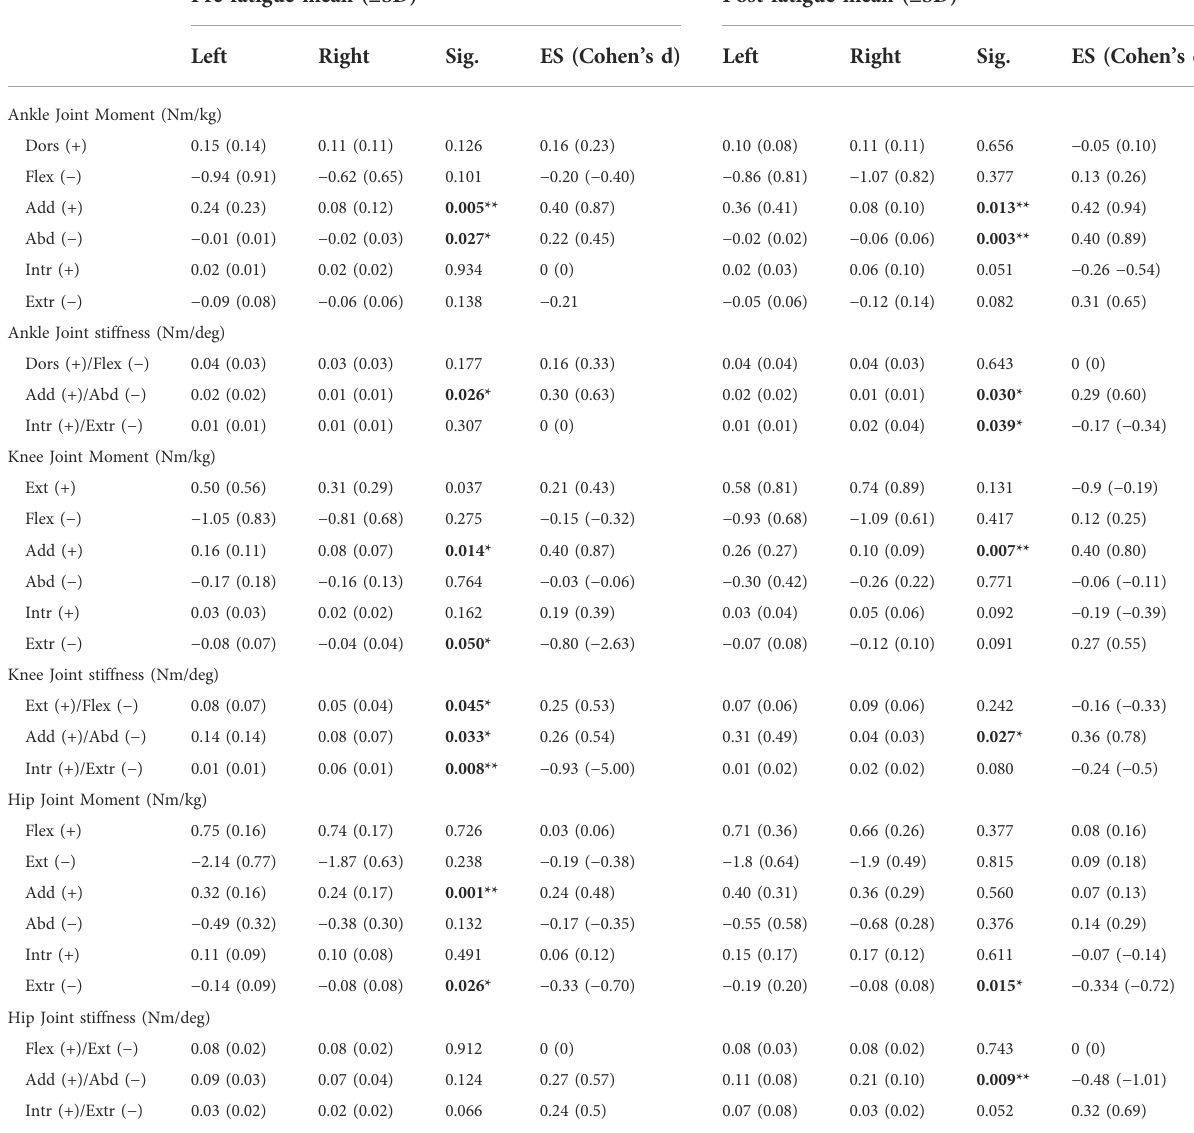
TABLE 1 Comparison of joint moment and joint stiffness of bilateral ankle, knee and hip joints before and after fatigue. Pre-fatigue mean (±SD) Post-fatigue mean (±SD) Left Right Sig. ES (Cohen ’ s d) Left Right Sig. ES (Cohen ’ s d)